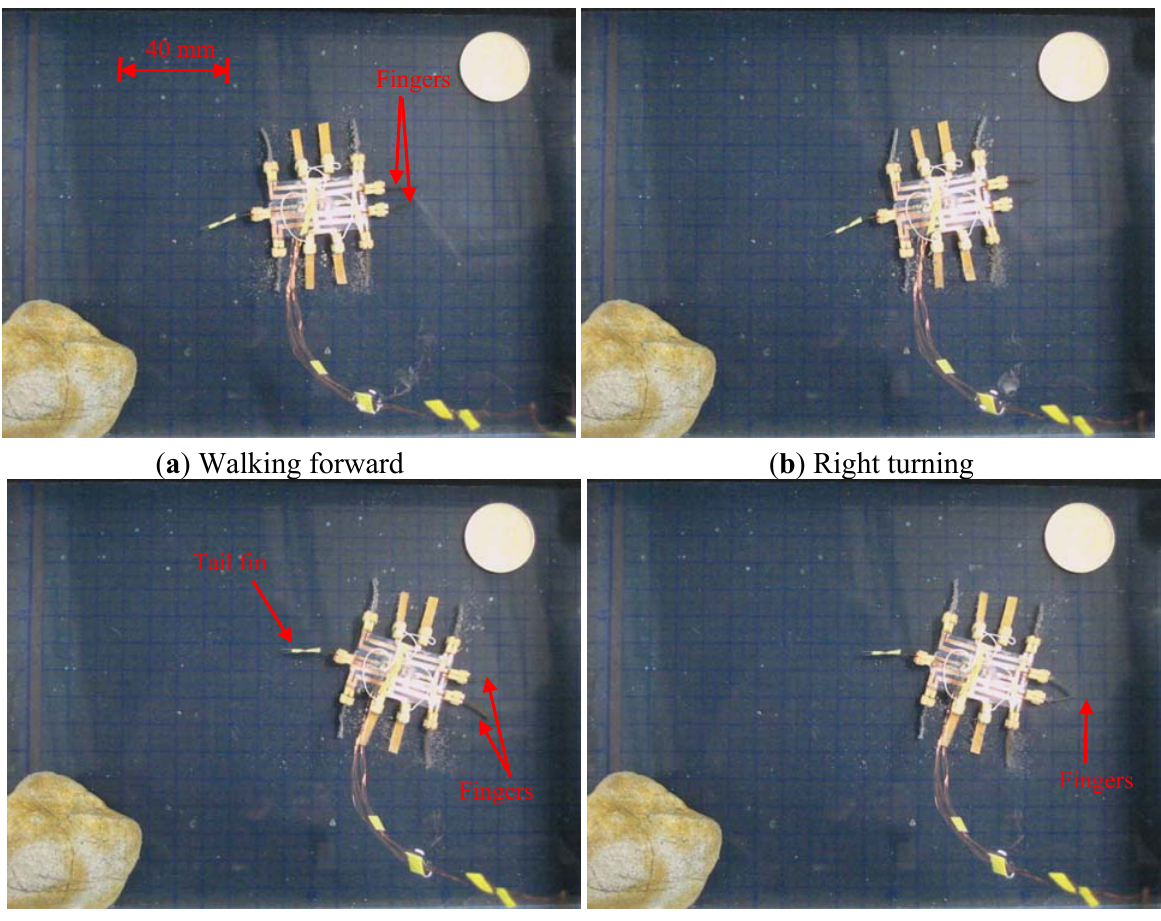
Figure 24. Walking, rotating, and grasping